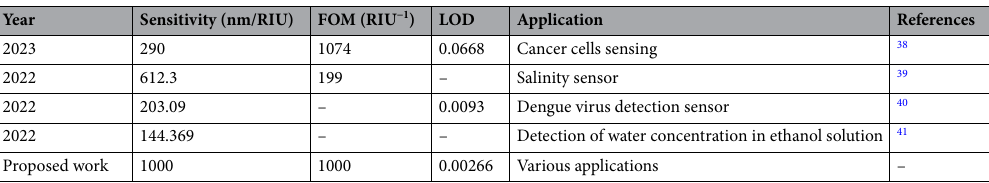
Table 5. Sensitivity comparison of the proposed sensor with previously reported